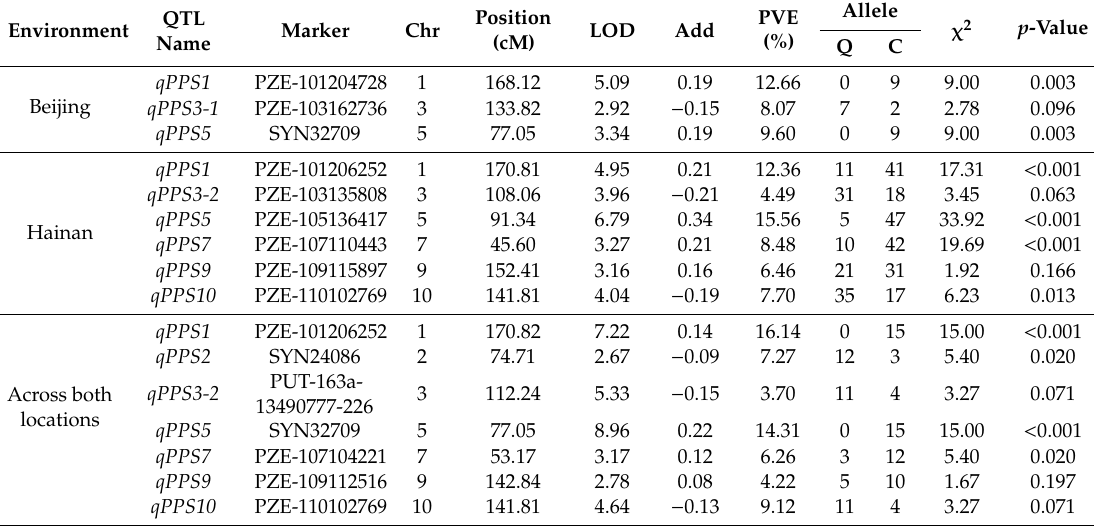
Table 3. Putative QTL detected for PPS in the haploid mapping